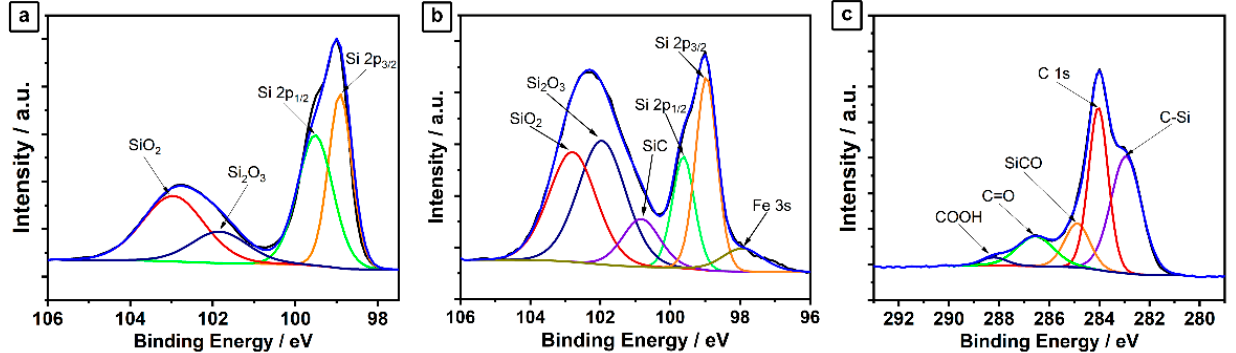
Figure 4. XPS high-resolution spectra: ( a ) Si 2p spectra of Si30h, ( b ) Si 2p spectra of Si30h/CNT, and ( c ) C 1s spectra of Si30h/CNT. ( c ) C 1s spectra of